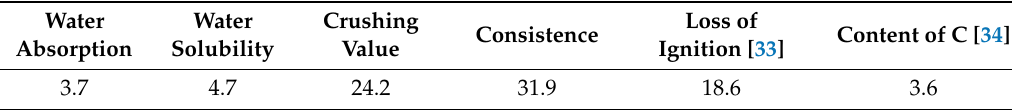
Table 1. Basic physical parameters of coal gangue /